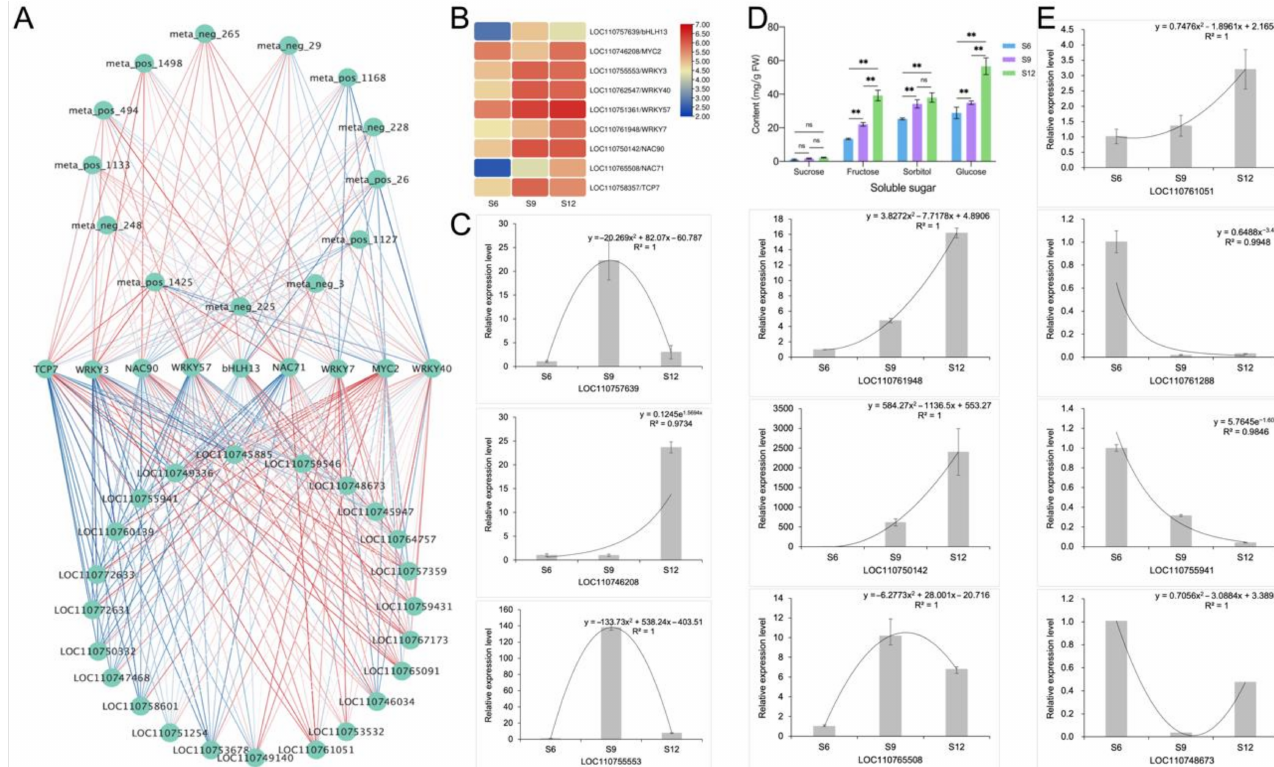
Figure 9. Identification and validation of glucose metabolism-related networks. ( A ) Correlation network identification of 9 transcription factors with DEMs and DEGs related to sugar anabolism. Correlations are represented by blue and red lines from low to high. ( B ) Expression patterns of colors indicating the relative content of each transcription factor, from low (blue) to high (red).